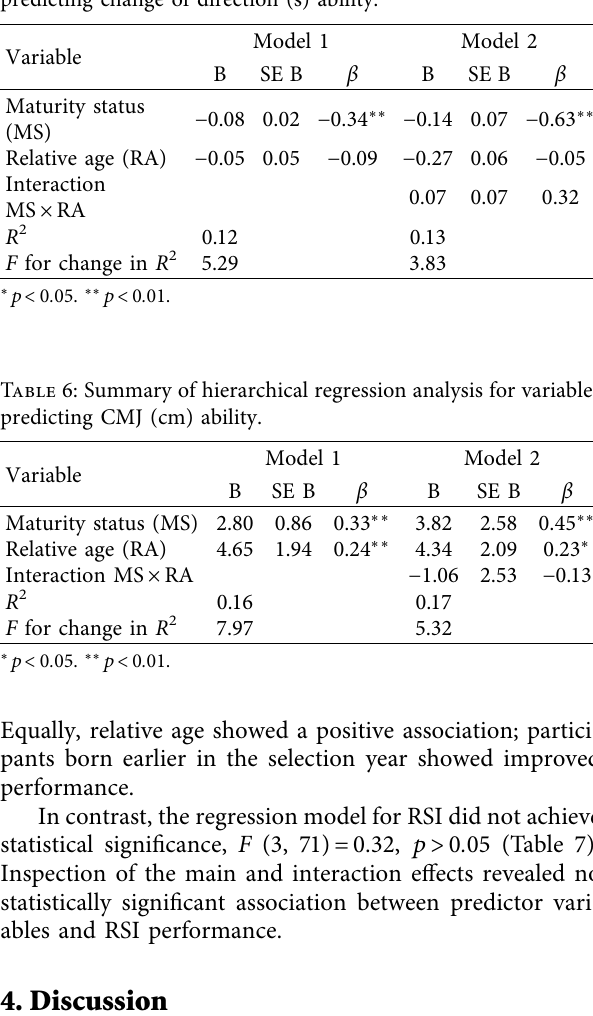
Table 5: Summary of hierarchical regression analysis for variables predicting change of direction (s) ability.